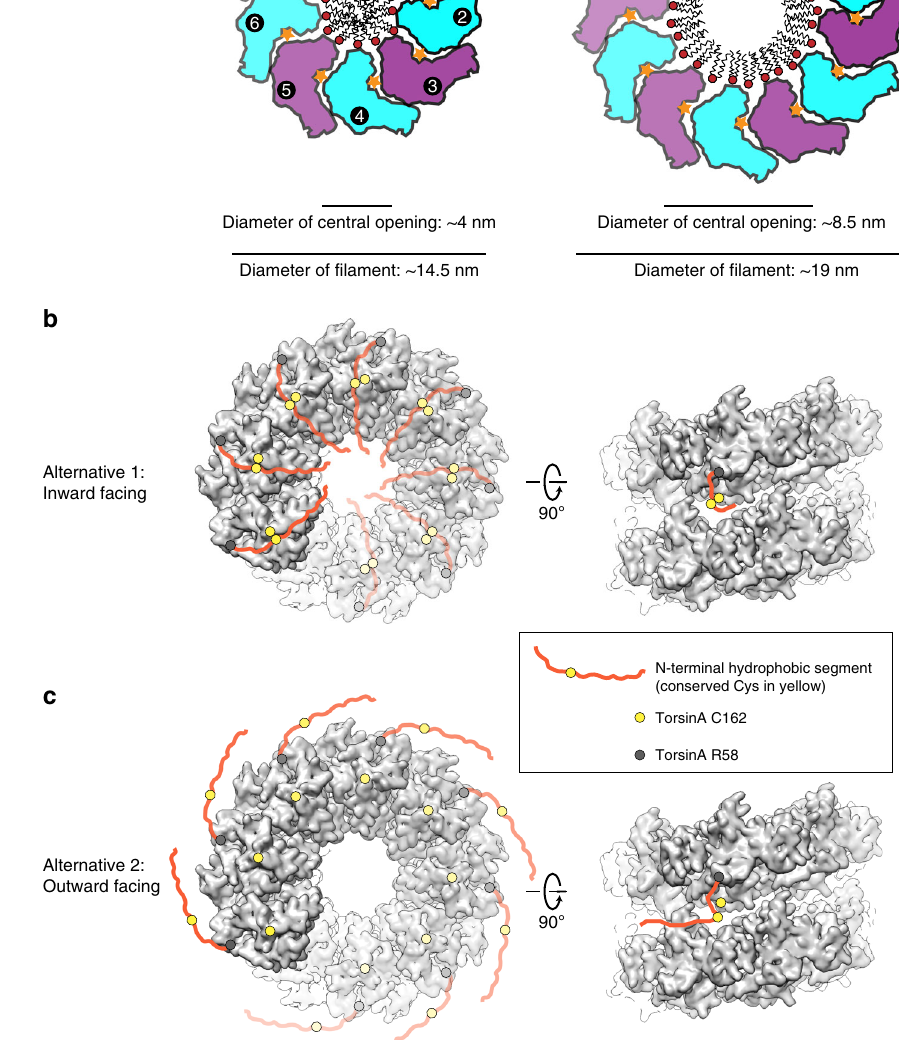
Fig. 6 Model for the functioning of TorsinA fi laments. a Schematic drawings of TorsinA fi laments illustrate how TorsinA may engage the membrane in liposome protrusions. The left panel displays the fi laments reconstructed by cryo-EM, whereas the right panel is modeled based on the average diameter of TorsinA-coated liposome protrusions shown in Fig. 3. In either case, TorsinA is envisioned to wrap around a lipid tube bulging from the liposome surface. b , c Torsin ’ s N-terminal hydrophobic portion is depicted in two alternative states on the reconstructed TorsinA fi laments. The fi rst structured residue on torsin ’ s N terminus (TorsinA R58) is marked as a gray circle, whereas the Cys162 is shown as a yellow circle. The N-terminal hydrophobic segment of TorsinA is conceived to be freely moving either toward inside (alternative 1) or outside (alternative 2) of the fi laments. The yellow circle on the hydrophobic segment marks Cys49/50, which come in close contact with Cys162 in the inward facing